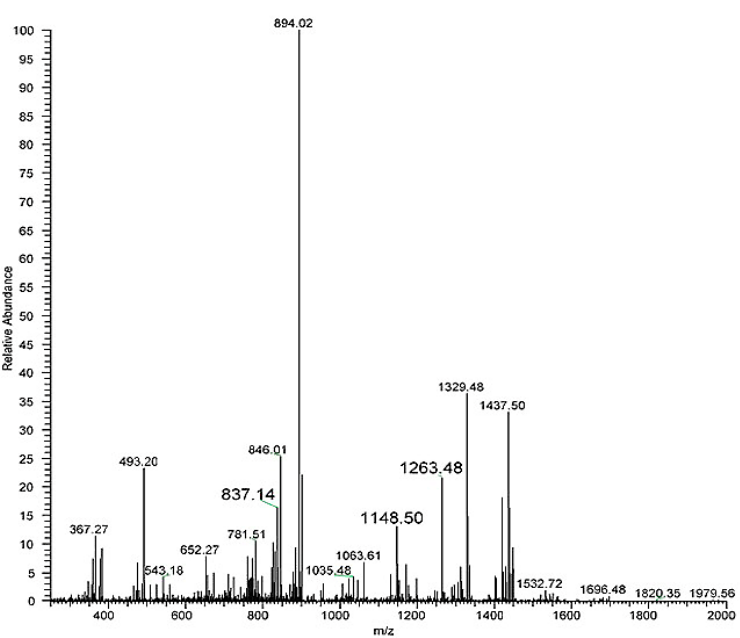
Figure A2. MS 3 spectrum obtained from the fragmentation of the doubly charged ion identified in the HRMS/MS spectrum. Relative abundance is on the y axis, mass-to-charge ( m / z ) ratio on the x axis.